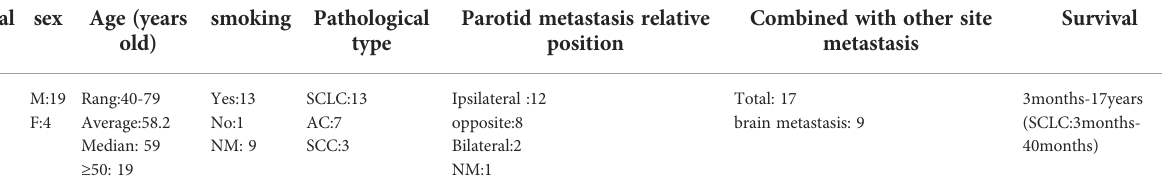
TABLE 2 Summary of the characteristics of lung cancer parotid